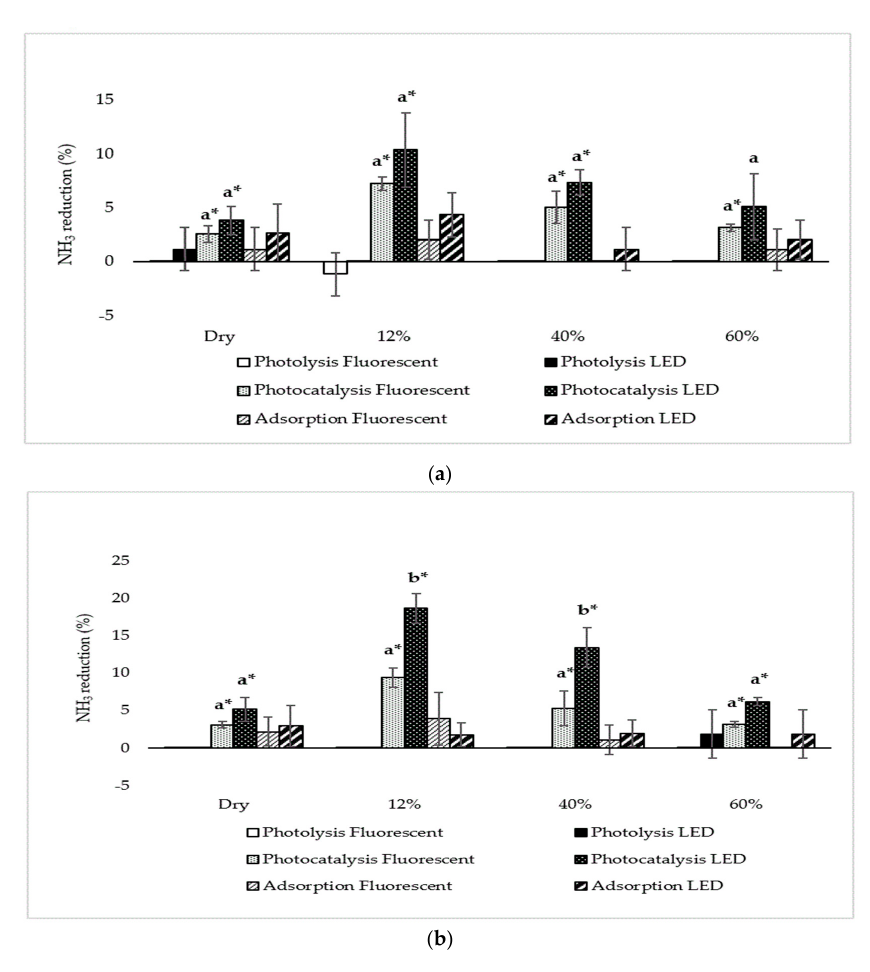
Figure 3. Comparison of NH 3 mitigation under different treatment types and light intensities. ( a ) % reduction at treatment time of 40 s; ( b ) % reduction at treatment time of 200 s; Superscript (*) signifies a statistical difference compared to the control ( p < 0.05), and the different characters (a, b) signify statistical di ff erence when comparing di ff erent light intensities (fluorescent vs. LED) at the same relative humidity ( p < 0.05). The % reduction was the highest at 12% (7.3–18.7%, p < 0.05). Error bars signify ± standard